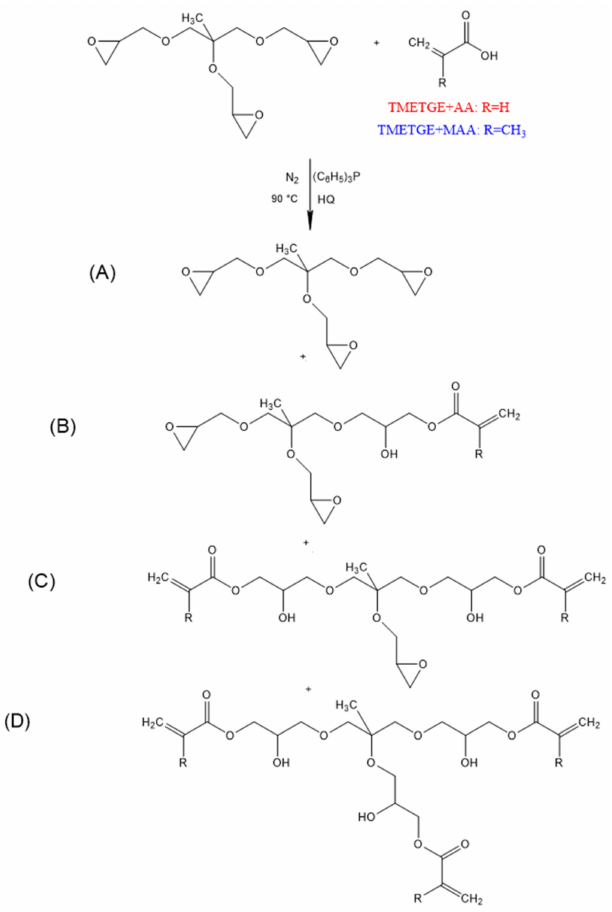
Figure 1. Synthesis of TMETGE-AA and TMETGE-MAA prepolymers by transesterification